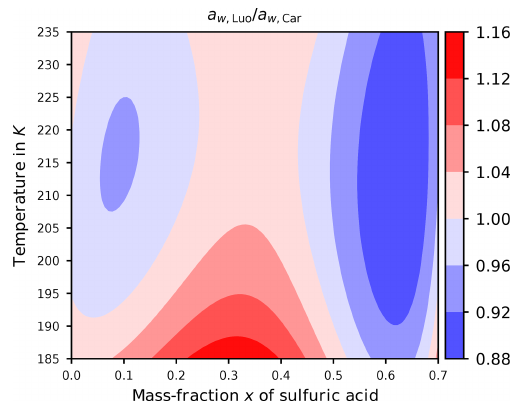
Figure 4. Ratio of the formulations (ii) and (iii) (i.e., Eqs. B2 and B3) for the water activity after Luo and Carslaw as a function of temperature T and mass fraction x of sulfuric acid.